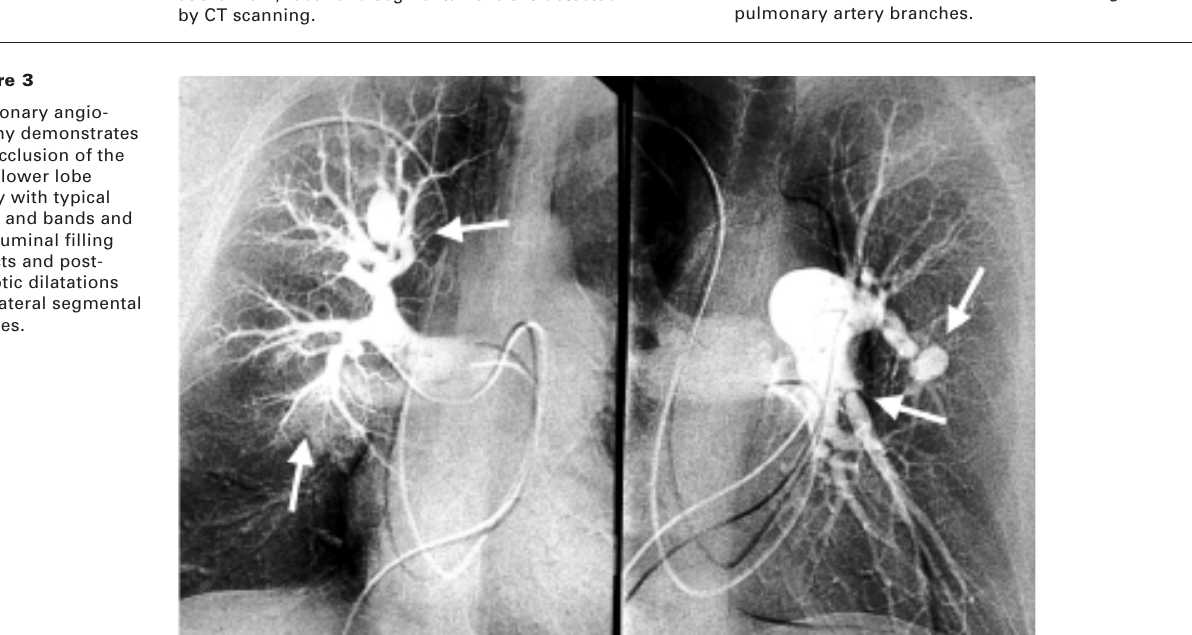
Three-dimensional MR angiography can precisely depict thromboembolic lesions down to the subsegmental pulmonary artery branches.